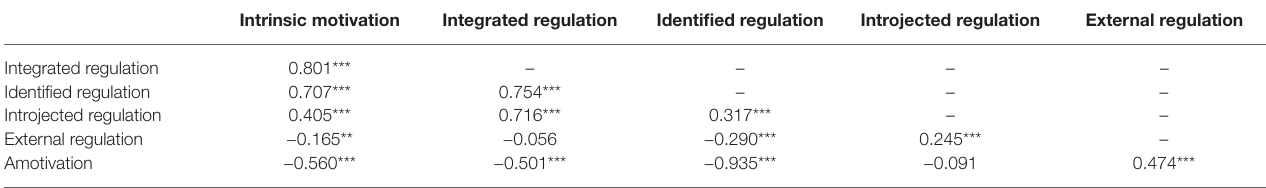
TABLE 2 | Correlations among subscales of the Chinese